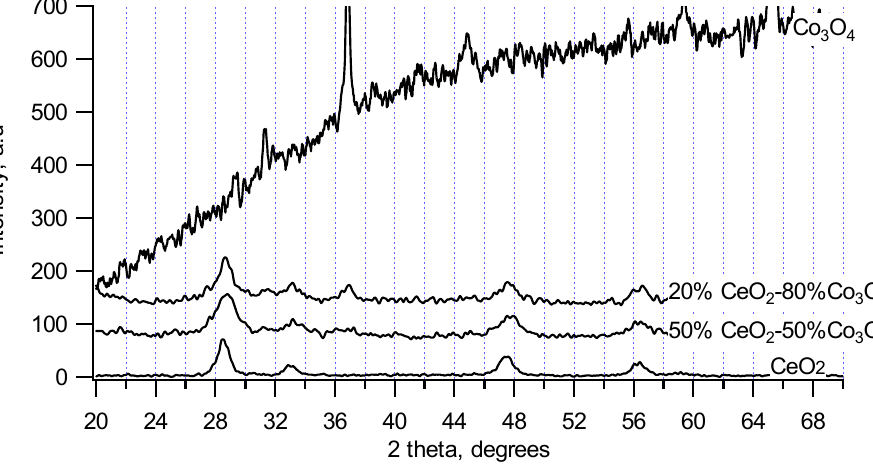
Figure 5. X-ray patterns of CeO 2 -Co 3 O 4 chemical